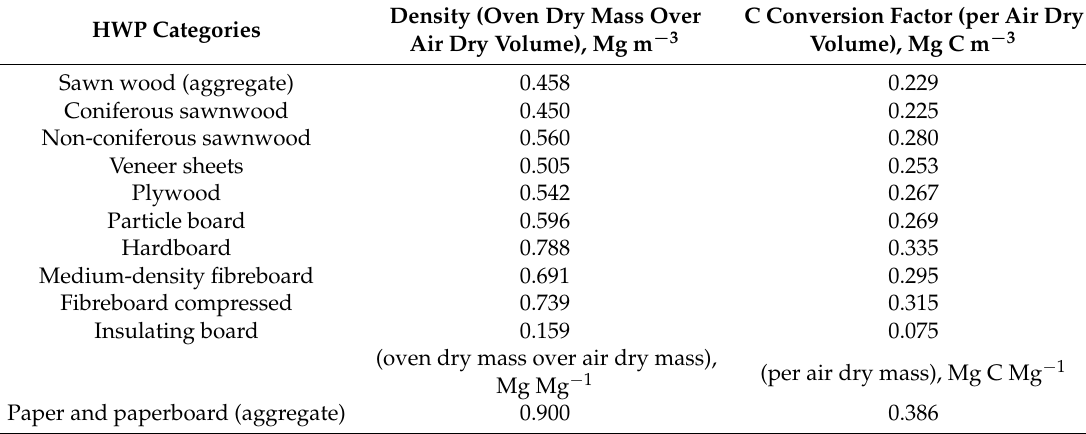
Table 2. Default conversion factors for the default harvested wood products (HWP) categories, adapted from [4].